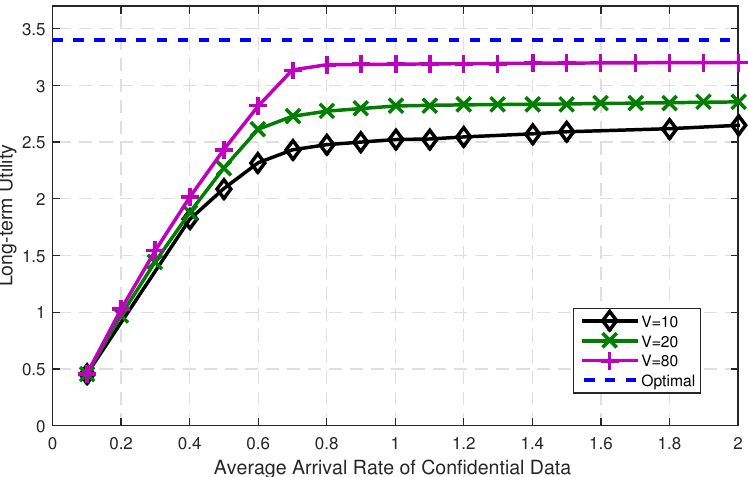
Figure 3. Long-term utility with varying confidential data arrival